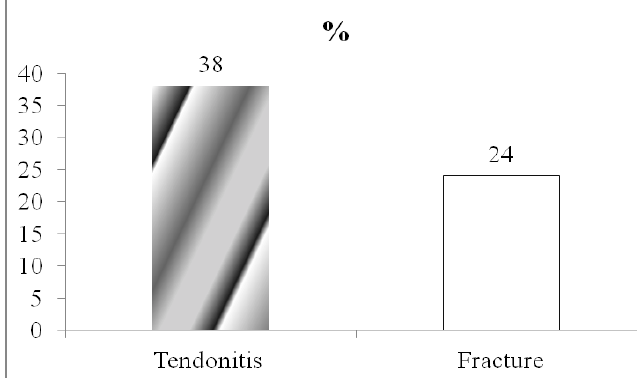
Figure 6. The usual type of injury in race walking